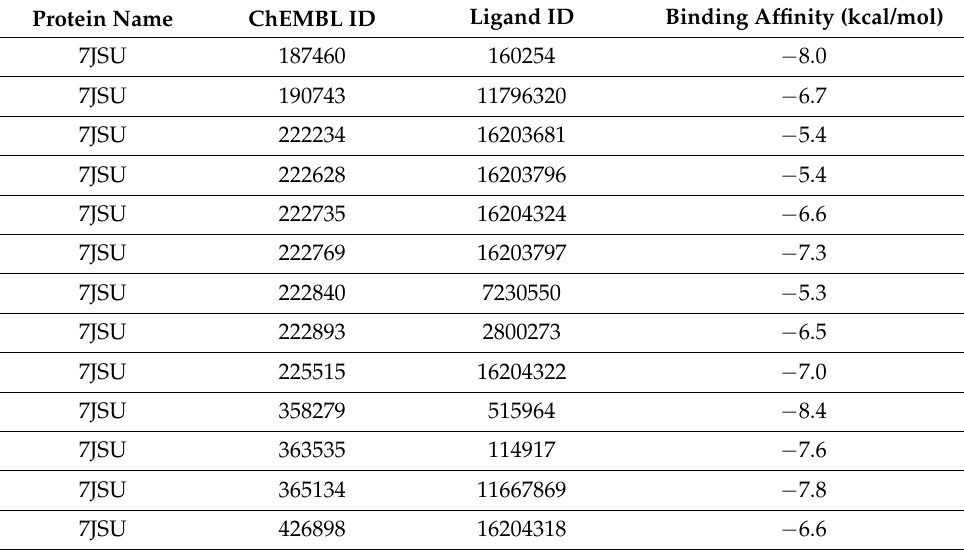
Table 5. Docking results of thirteen selected ligands towards the target protein